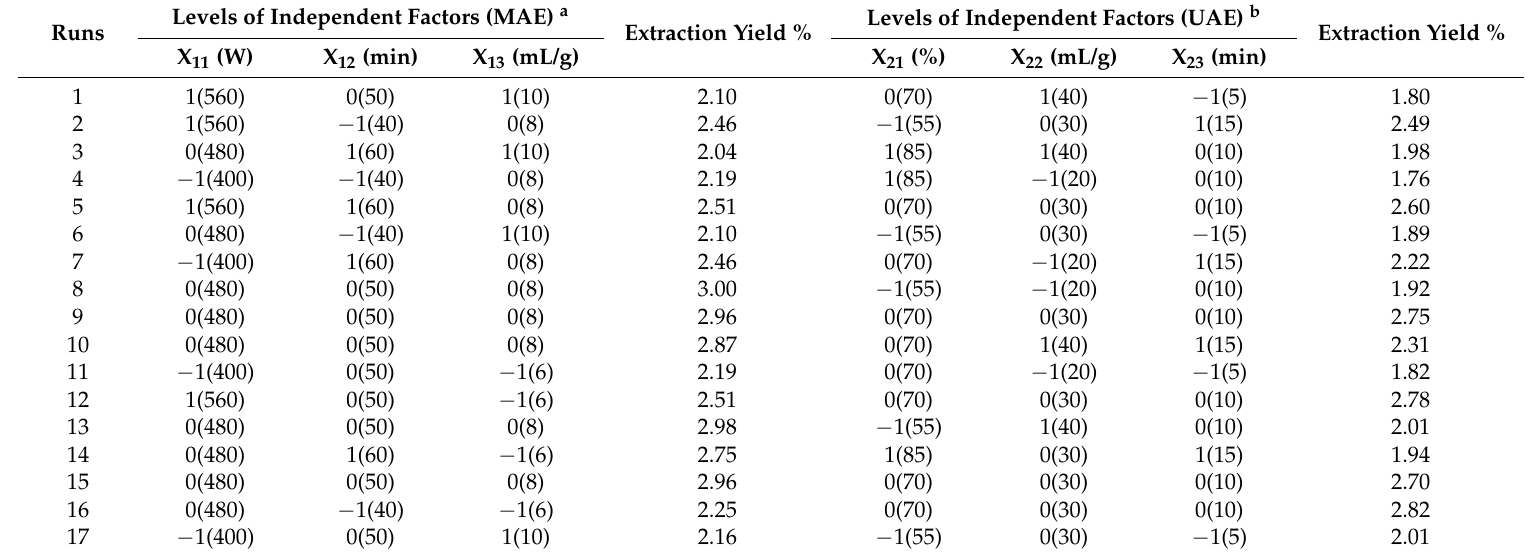
Table 1. Box–Behnken design with independent variables and observed values for microwave-assisted extraction (MAE) and ultrasonic-assisted extraction (UAE). Levels of Independent Factors (MAE) a Levels of Independent Factors (UAE) b Runs Extraction Yield % Extraction Yield % X 11 (W) X 12 (min) X 13 (mL/g)